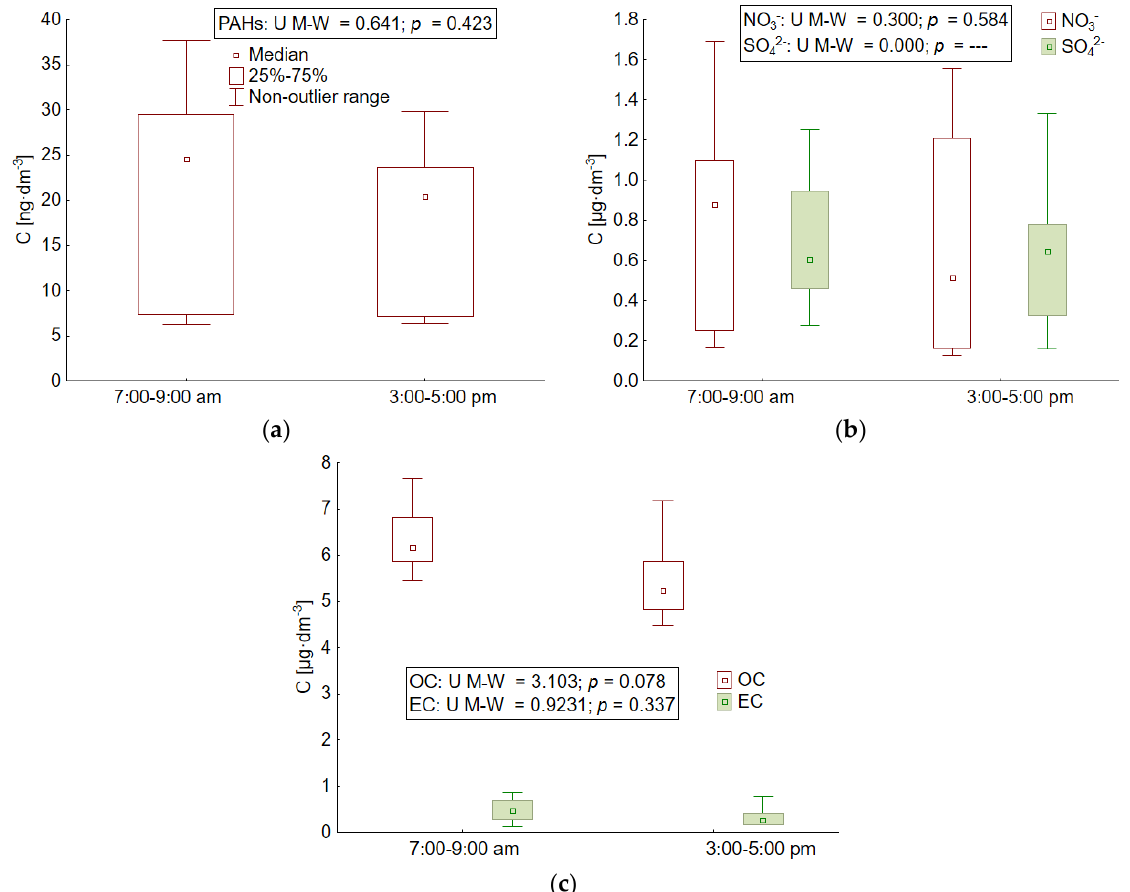
Figure 3. Statistical characteristics of the concentration of ( a ) PAH 5 , ( b ) nitrate and sulphate ions, ( c ) and OC and EC in the morning and afternoon rush hours in the atmosphere over Gdynia during the holiday season of 2015.